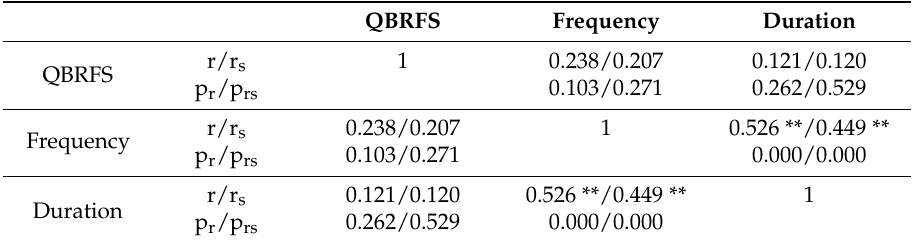
Table 7. Statistical correlation between the questionnaire for benefits of recreational figure skating and frequency, and duration of practicing figure skating during recreational